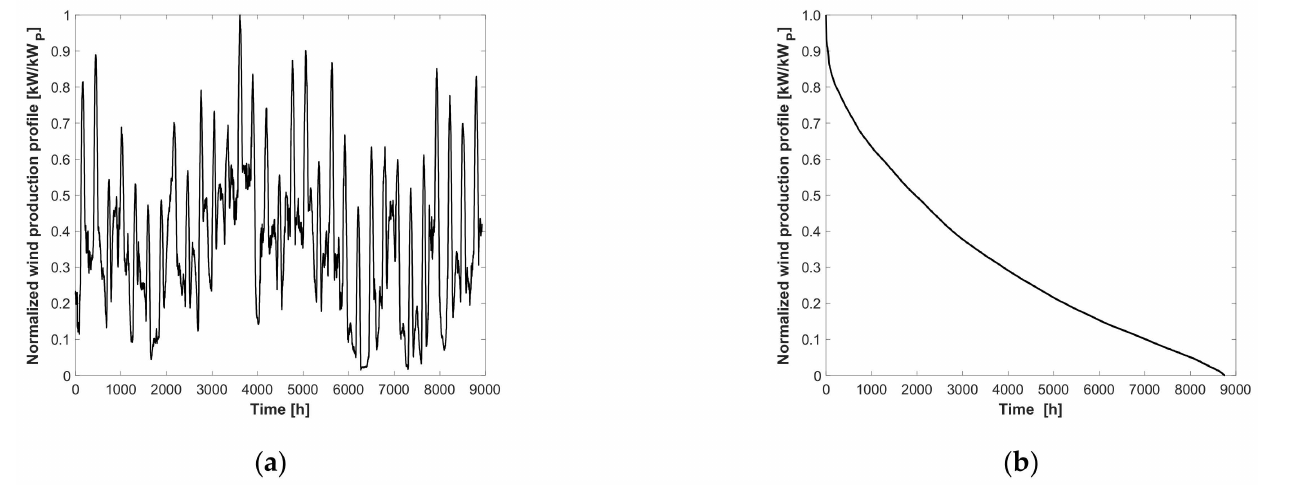
Figure 4. Normalized annual wind production profile (figures elaborated using data by TERNA [24,25], data referring to year 2019, Italy): ( a ) instantaneous curve and ( b ) monotonic duration